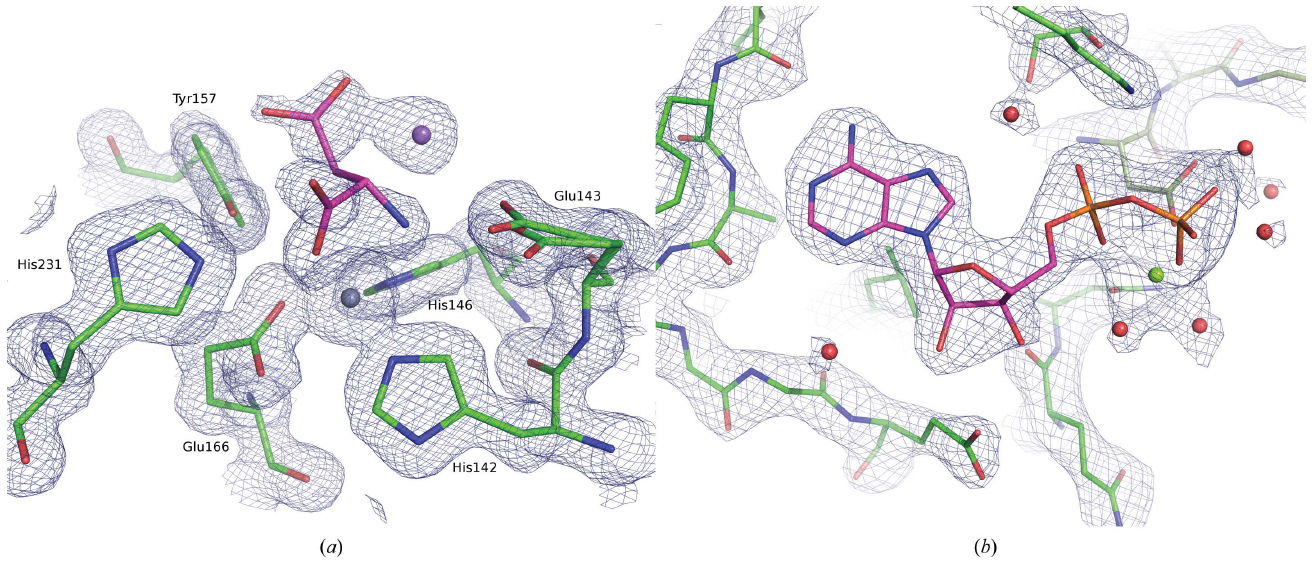
Figure 11 Ligand-binding sites of the structures obtained from on-chip ligand-soaking experiments using our crystallization chambers and Roadrunner I chips. ( a ) An aspartate molecule (pink) in complex with a sodium ion (purple sphere) is bound to the active site of thermolysin. It is involved in the fivefold coordination of the catalytic zinc ion (gray sphere) with both its amino and carboxy moieties. The 2 mF o (cid:5) DF c electron-density map at 1 (cid:5) is shown as a blue mesh and catalytically important thermolysin residues (green) are labeled. ( b ) The 2 mF o (cid:5) DF c electron-density map at 1.5 (cid:5) clearly indicates the presence of Mg 2+ -ADP (yellow sphere and pink sticks) at the active site of